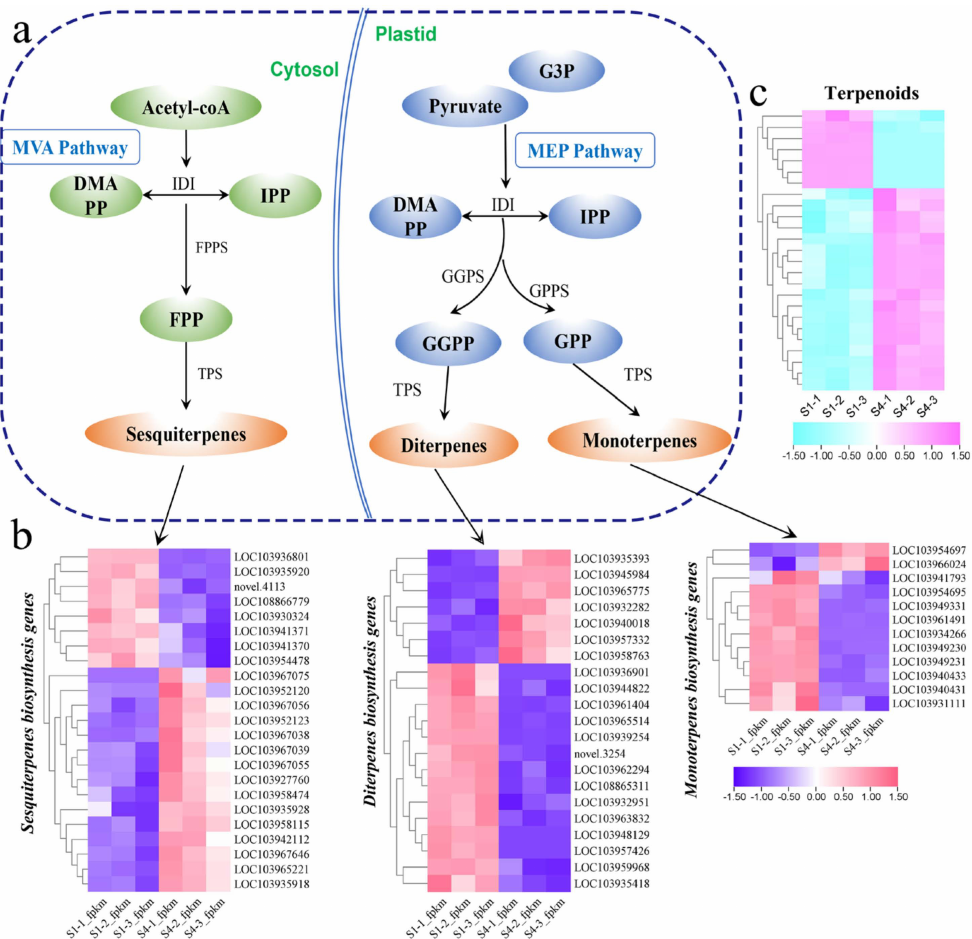
Figure 4. Differential gene expression patterns of two terpenoid biosynthetic pathways for fruits in stages S1 and S4. ( a ) Biosynthetic pathway of terpenoids in plants. Terpenoid precursors (acetyl-CoA and pyruvate) enter the MVA pathway in the cytosol to generate sesquiterpenes or the MEP pathway in plastids to form monoterpenes and diterpenes. The enzymes and intermediates of both pathways are shown. ( b ) DEGs for monoterpenes, diterpenes, and sesquiterpenes biosynthesis pathways. ( c ) Differential terpenoids. DMAPP: dimethylallyl diphosphate; FPP: farnesyl diphosphate;